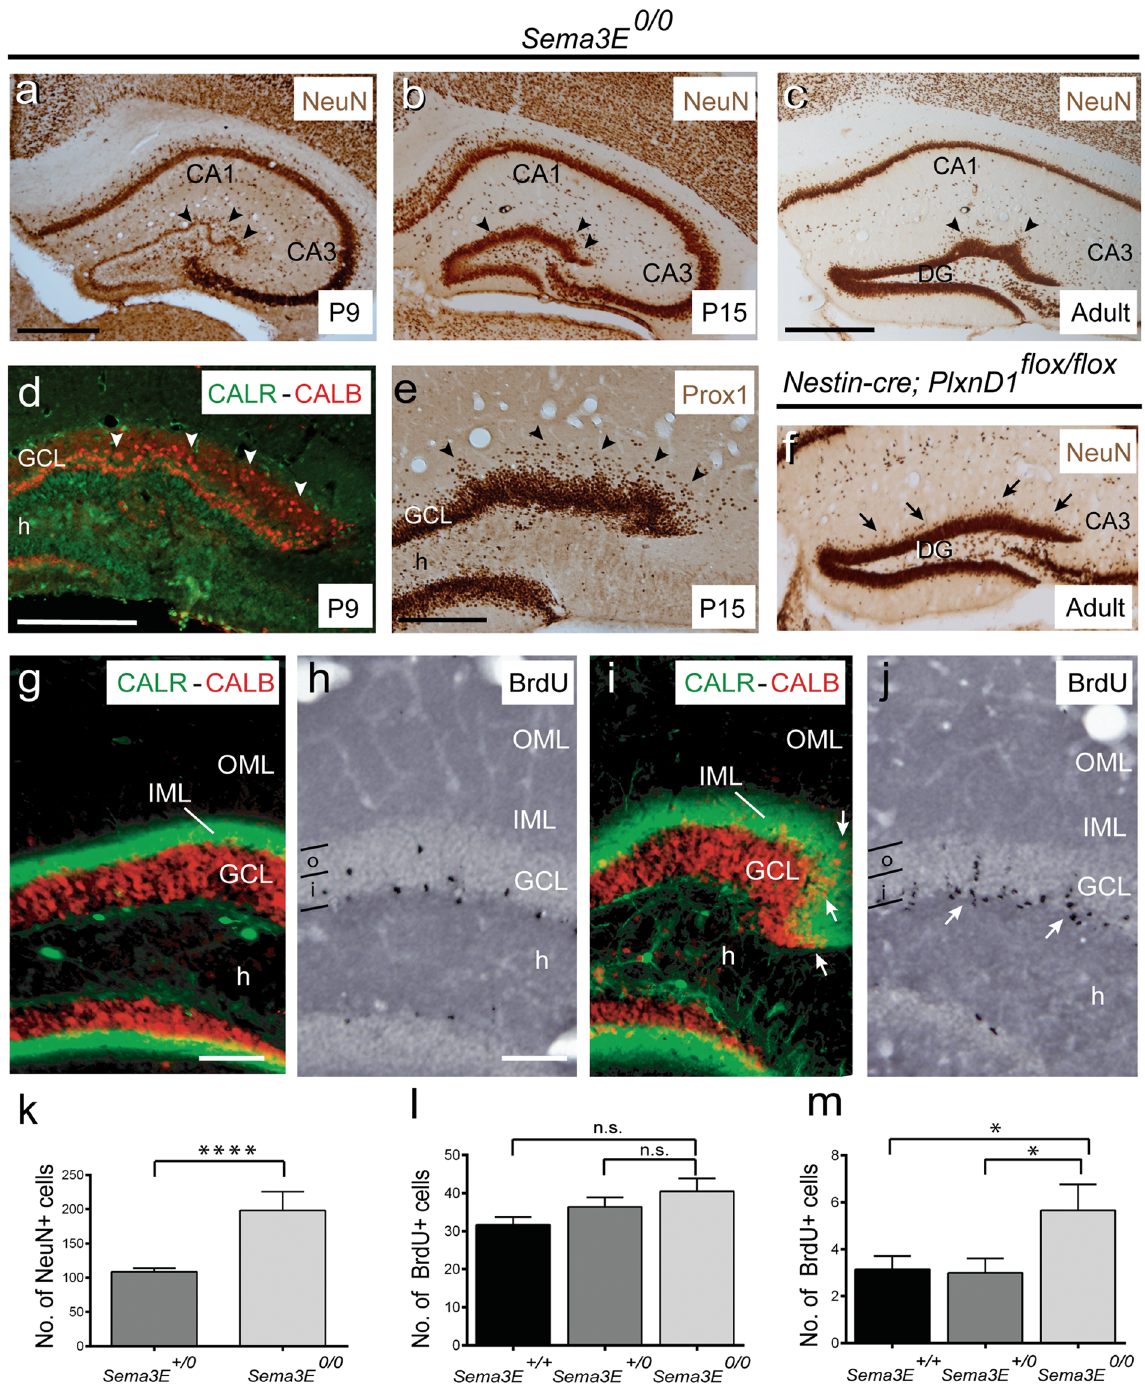
Figure 4. Examples of α -NeuN immunostaining in the hippocampus proper and dentate gyrus of Sema3E 0/0 ( a – c ) and Nestin-cre ; PlxnD1 flox/flox ( f ) mice at different postnatal stages. Note the presence of numerous NeuN- positive cells in the molecular layer in absence of Sema3E/PlexinD1 signalling (arrowheads), especially in Sema3E-deficient mice. Also note the presence of several waves of the suprapyramidal blade of dentate gyrus. ( d ) Double immunolabeling of Calretinin (green) and Calbindin (red) in the dentate gyrus of Sema3E 0/0 mice at P9. Note the presence of numerous ectopic Calbindin-positive neurons in the IML of Sema3E 0/0 mice (arrowheads). ( e ) Prox-1 immunolabeling in the dentate gyrus of Sema3E 0/0 mice at P15 shows the presence of numerous Prox-1-positive granule cells in the molecular layer (arrowheads). ( g , i ) Double immunolabeling of Calretinin (green) and Calbindin (red) in the dentate gyrus of control ( g ) and Sema3E 0/0 adult mice ( i ). Note the presence of numerous ectopic Calbindin-positive neurons in the IML of Sema3E 0/0 mice (arrows in i ). ( h – j ) Examples of BrdU-labeled neurons in the granule cell layer of control ( h ) and Sema3E 0/0 ( j ) mice. Numerous BrdU-positive cells forming columns in the granule cell layer can be seen in mutant mice